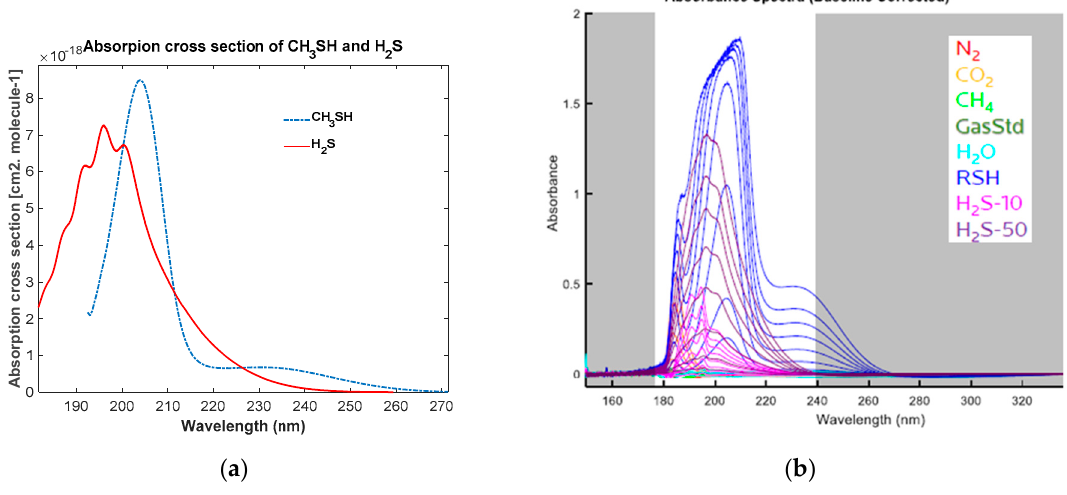
Figure 4. ( a ) Reference UV absorption cross sections of methyl mercapan CH 3 SH and hydrogen sulfide H 2 S at room temperature, the cross sections data were retrieved from the MPI-Mainz UV–vis Spectra Atlas [19,21]; ( b ) UV absorbance spectra of H 2 S (10 ppm and 50 ppm), RSH (CH 4 SH, 50 ppm), CO 2 , H 2 O, N 2 , and hydrocarbon gases mixture (GasStd), note that H 2 S (10 ppm and 50 ppm), CH 4 SH (50 ppm) were measured at multiple pressure at various pressures conditions from 96.5 kPa (14 psi) to 6894.7